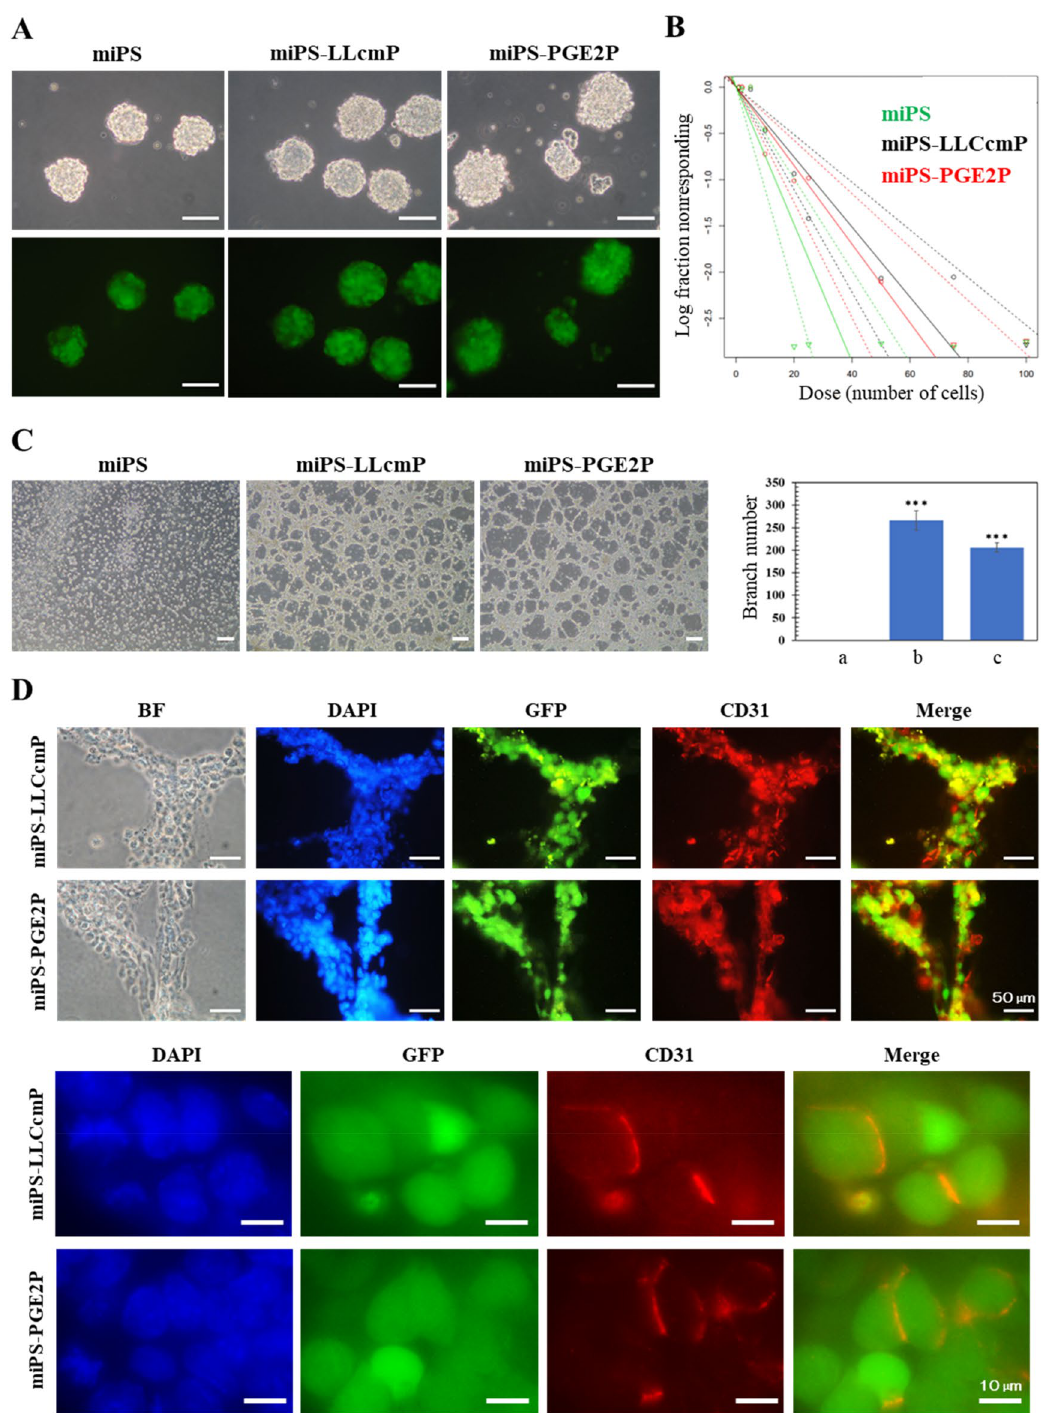
Figure 4. Self-renewal and differentiation potential of miPS-PGE2P cells compared with miPS-LLCcmP cells. ( A ) Typical spheres of the cells in non-adherent condition. Scale bar 100 µm. ( B ) ELDA for sphere formation miPS-PGE2P cells (Green), miPS-LLCcmP cells (red) and miPSCs (black). ( C ) Tube formation assay. Branching point analysed by ImageJ. a: miPS, b: miPS-LLCcmP, c: miPS-PGE2P. Data are plotted as means ± SD. *** p < 0.01 ( D ) Immunofluorescent analyses of tubes in ( C ). BF bright field, DAPI staining for nucleus, GFP fluorescence of GFP, CD31 staining with anti-CD31 antibody labelled with Alexa fluor 555. Scale bars 50 (top) and 10 µm